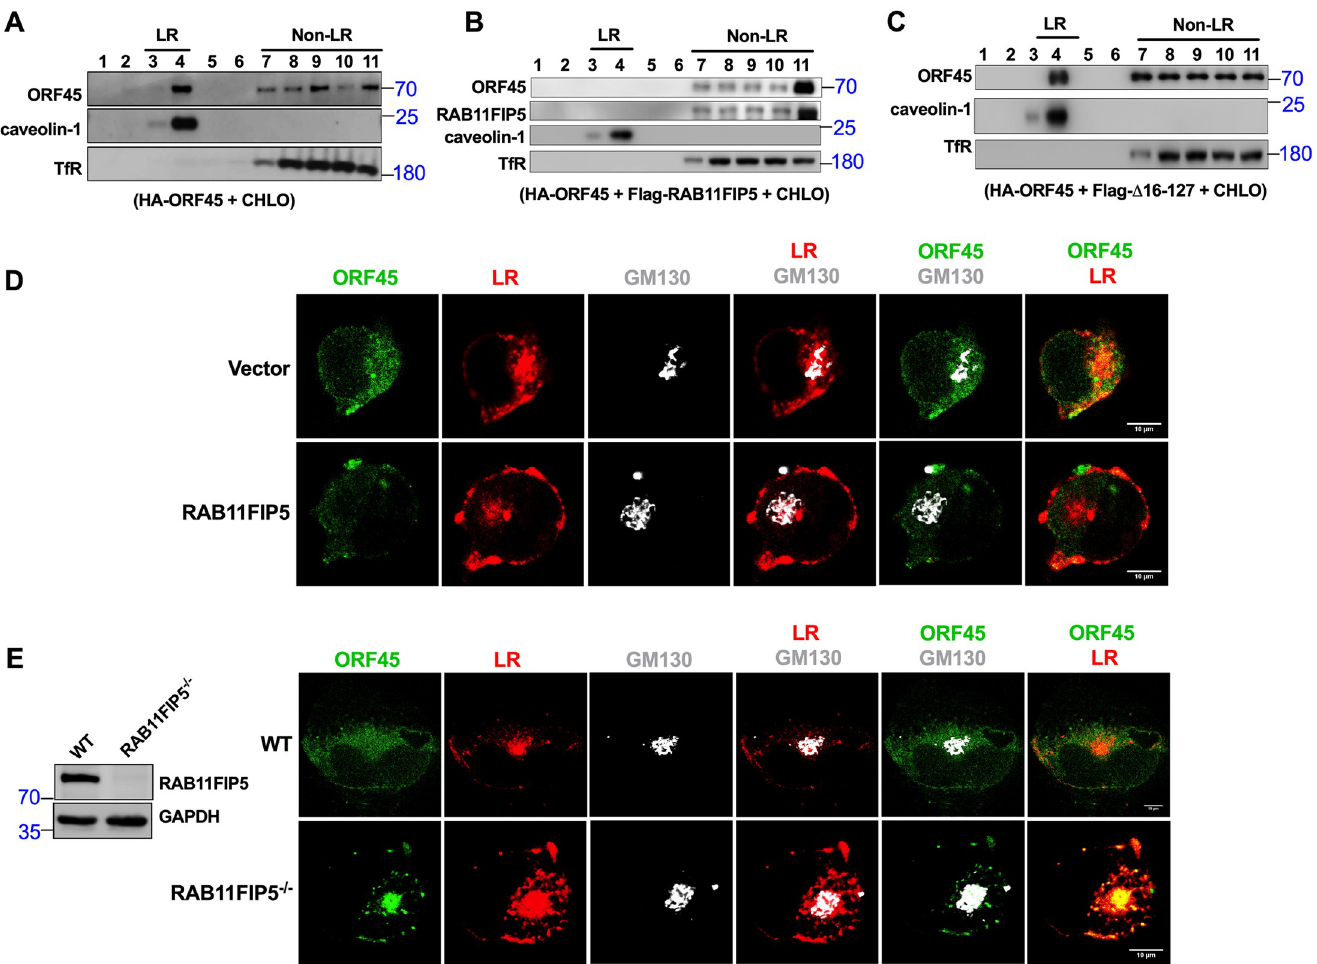
Fig 7. RAB11FIP5 inhibits ORF45 colocalization with LRs. (A) HEK293T cells were cotransfected with HA-ORF45 and Flag empty vector for 48 h and were then treated with CHLO for another 6 h. The cells were subjected to the membrane flotation assays as described in the Materials and Methods section. Eleven fractions (lanes 1–11) were collected (top to bottom) from samples subjected to sucrose gradient ultracentrifugation and analyzed by western blotting with specific antibodies as indicated. Caveolin-1 and TfR served as controls that defined the LR (lanes 3–4) and non-LR (lanes 7–11) fractions, respectively. (B) HEK293T cells were cotransfected with HA-ORF45 and Flag-RAB11FIP5 for 48 h and were then treated with CHLO for another 6 h. The cells were subjected to membrane flotation assays as described above. (C) HEK293T cells were cotransfected with HA-ORF45 and RAB11FIP5 C2 domain deletion mutant Flag- Δ 16–127 for 48 h and were then treated with CHLO for another 6 h. The cells were subjected to the membrane flotation assays as described above. (D) Stable clones of HeLa-Vector and HeLa-RAB11FIP5 cells were transfected with the ORF45 plasmid. Twenty-four hours after transfection, the cells were treated with CHLO for 6 h and were then incubated with CTB-555 at 37˚C for 30 min. Triple-label IFA was performed using CTB-555, rabbit polyclonal anti-GM130 and mouse monoclonal anti-ORF45 antibodies as described in the Materials and Methods section. Alexa Fluor 488-conjugated anti-mouse IgG (green) and Alexa Fluor 647-conjugated anti-rabbit IgG (white) were used as the corresponding secondary antibodies. (E) Stable clones of HeLa-WT and HeLa-RAB11FIP5 -/- cells were isolated and expanded from the monoclonal cell population by using the limiting dilution method. RAB11FIP5 knockout was confirmed by western blotting. Stable clones of HeLa-WT and HeLa-RAB11FIP5 -/- cells were transfected with the ORF45 plasmid. Twenty-four hours after transfection, the cells were treated with CHLO for 6 h and were then incubated with CTB-555 at 37˚C for 30 min. Triple-label IFA was performed as described